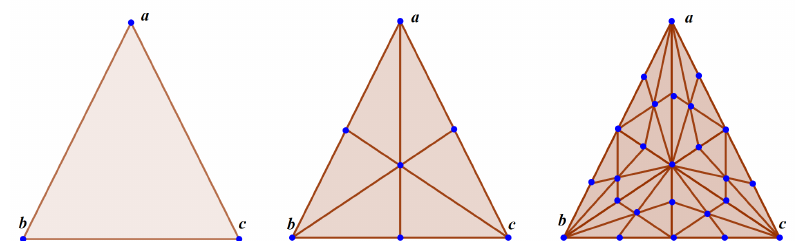
Figure 1. Example of a barycentric subdivision. Let V = { a , b , c } be the set of the three vertices (in blue) of the triangle depicted on the left. Let K = {{ a } , { b } , { c } , { a , b } , { a , c } , { b , c } , { a , b , c }} . From left to right: | K | , | Sd K | , and | Sd 2 K | are